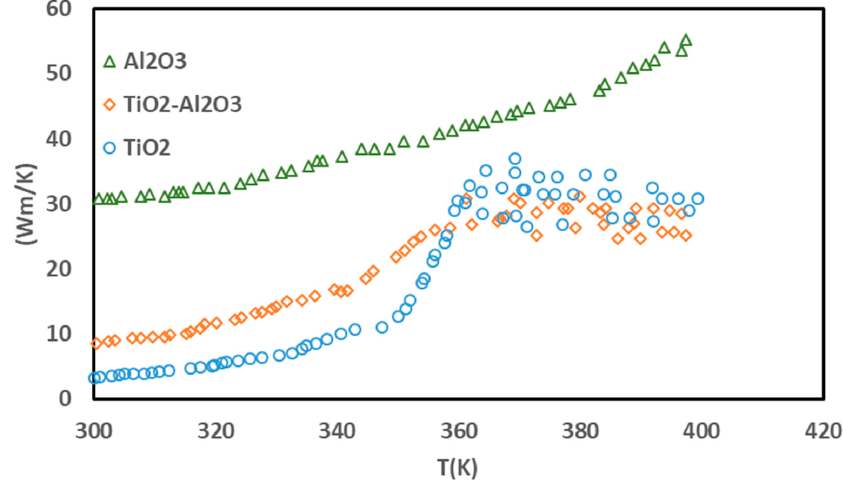
Figure 4. The results of the thermal conductivity coefficient of the nanocomposite.